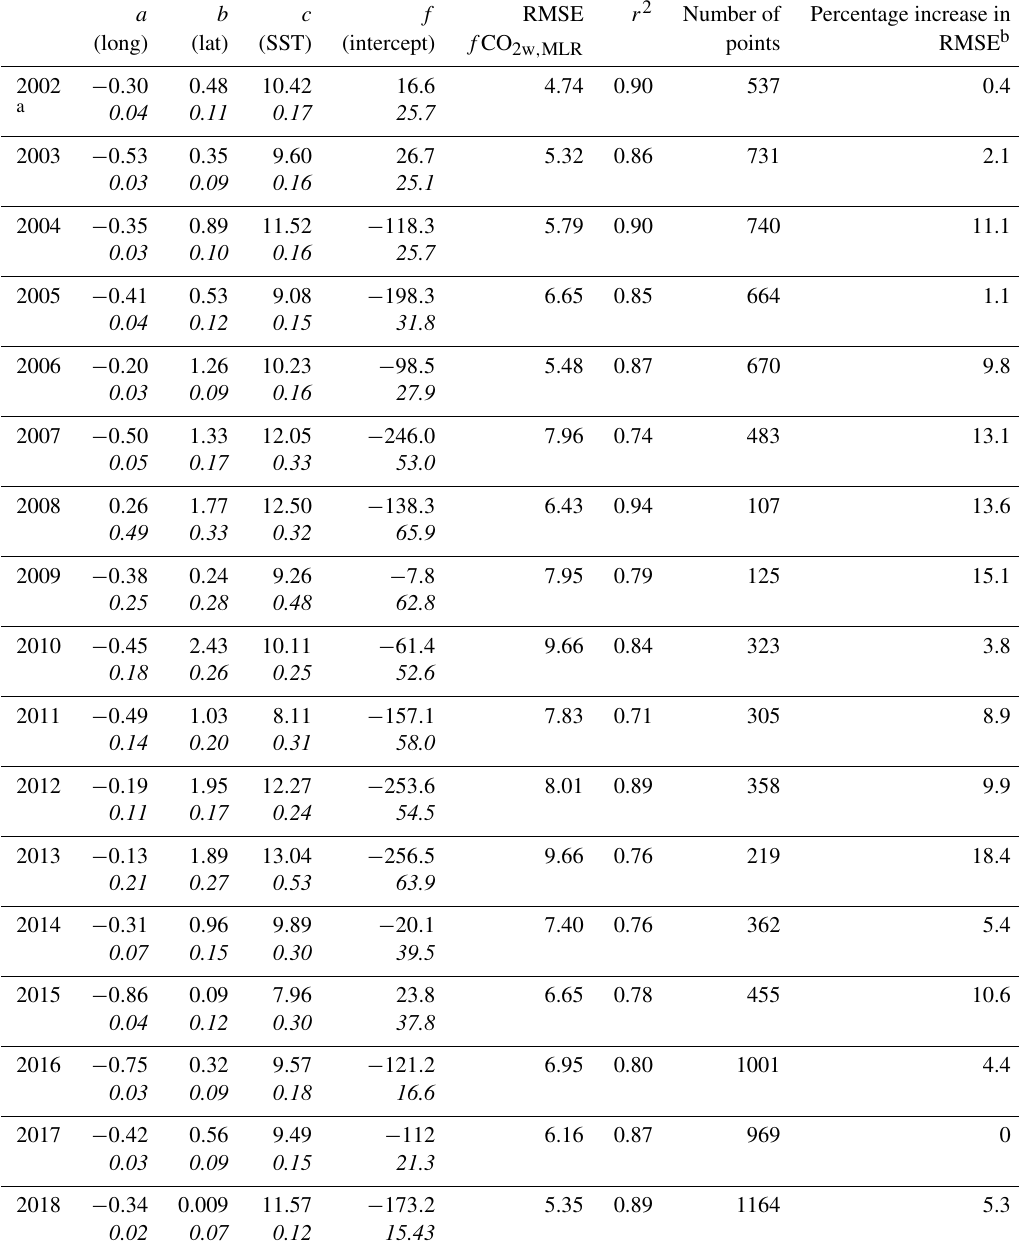
Table A1. Coefficients for the MLR, f CO 2w , MLR = a long + b lat + c SST + e SSS + f